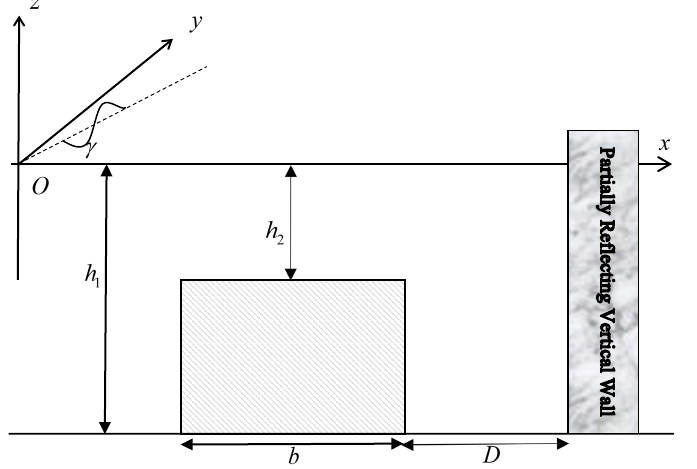
Figure 2. Problem definition of wave scattering by a rectangular breakwater near a partially reflecting wall.